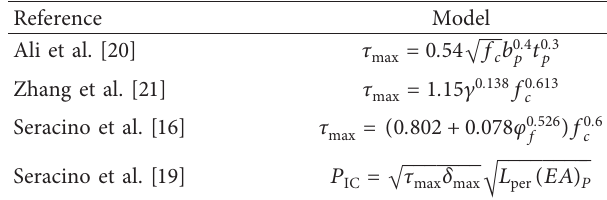
Table 1: Selected bonded joints strength